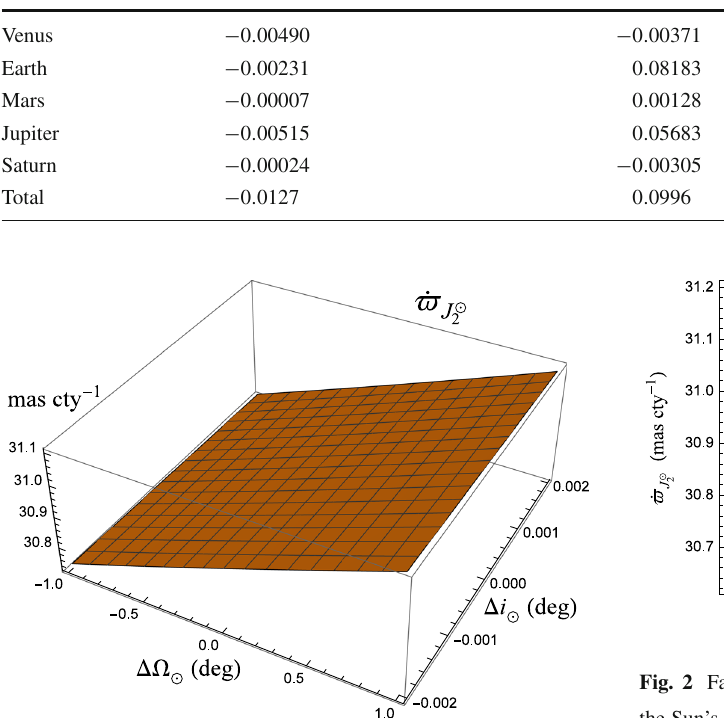
Fig. 1 Plot of ˙ (cid:2)